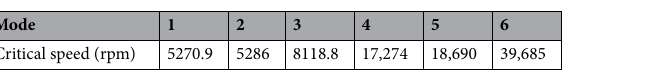
Table 4. Critical speeds of the rotor